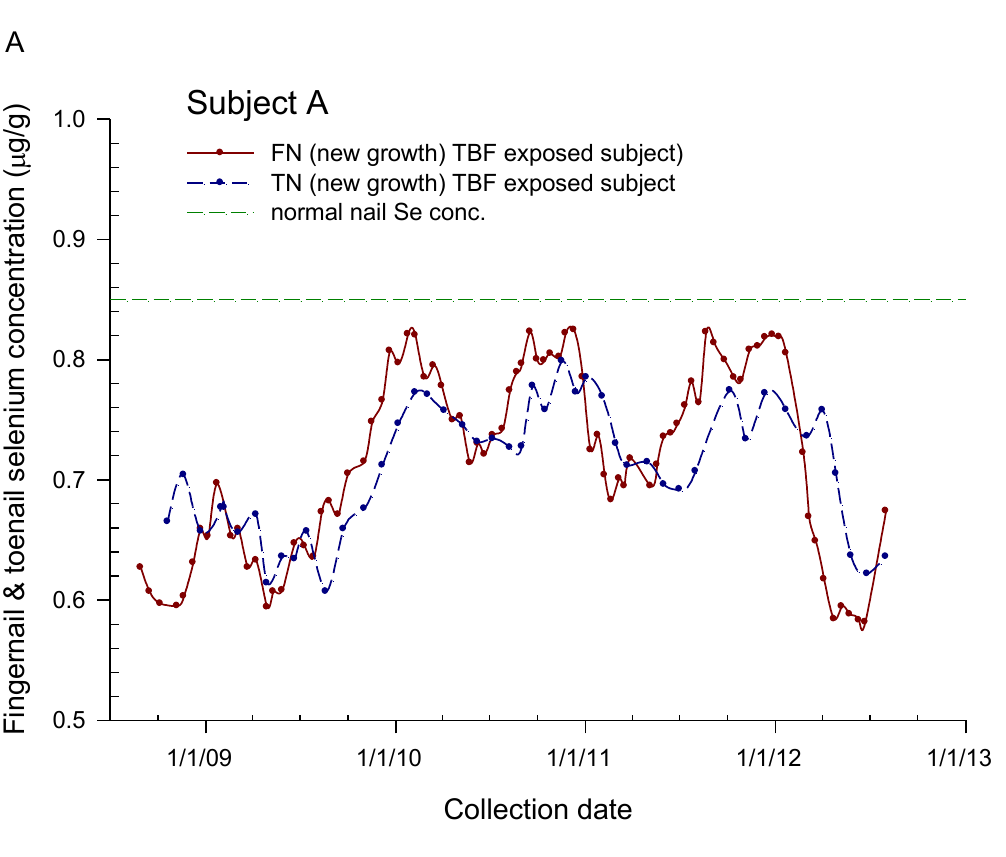
Figure 5. Post-exposure, post-peak temporal response in new-growth fingernail and toenail Se concentrations (μg/g) in Subject A ( A ) and in comparison to 2 other unexposed male subjects who do not use Se supplements ( B ). The post-exposure restored baseline for Subject A has been measured in new-growth FN and TN samples collected twice-a-month for FNs and once-a-month for TNs over approximately 4 years. Each FN and TN data point in (A) is the mean of 10 individual FN and TN clipping samples taken individually from each nail and analyzed separately. Done in this way each data point integrates dietary Se intake over an estimated 2 weeks for FNs and 4 weeks for TNs in the context of the temporal response profiles. For both FNs and TNs the post-exposure restored baselines cycle with a near annual period while remaining below the normal Se concentration expected for this subject (0.85 μg/g). As expected, the TN monitor lags somewhat behind the FN monitor. The post-exposure restored baselines for Subject A (male, Caucasian, non-smoker) are compared to 2 male subjects of comparable age, race, diets, and BMI in ( B ). The 2 comparison subjects have, for over 20 years, participated in a Missouri study of Se status in which they provide FN and TN samples on a quarterly schedule. The quarterly FN and TN samples include clippings from all FNs in the FN sample and all TNs in the TN sample. Representative aliquots for analysis are prepared from the combined FN and TN quarterly samples. Neither Caucasian comparison-subject smokes cigarettes or takes a Se supplement. There has been a gradual increase in both FNSe and TNSe concentrations observed in both comparison subjects over the 20-year study period attributable to increasing dietary Se